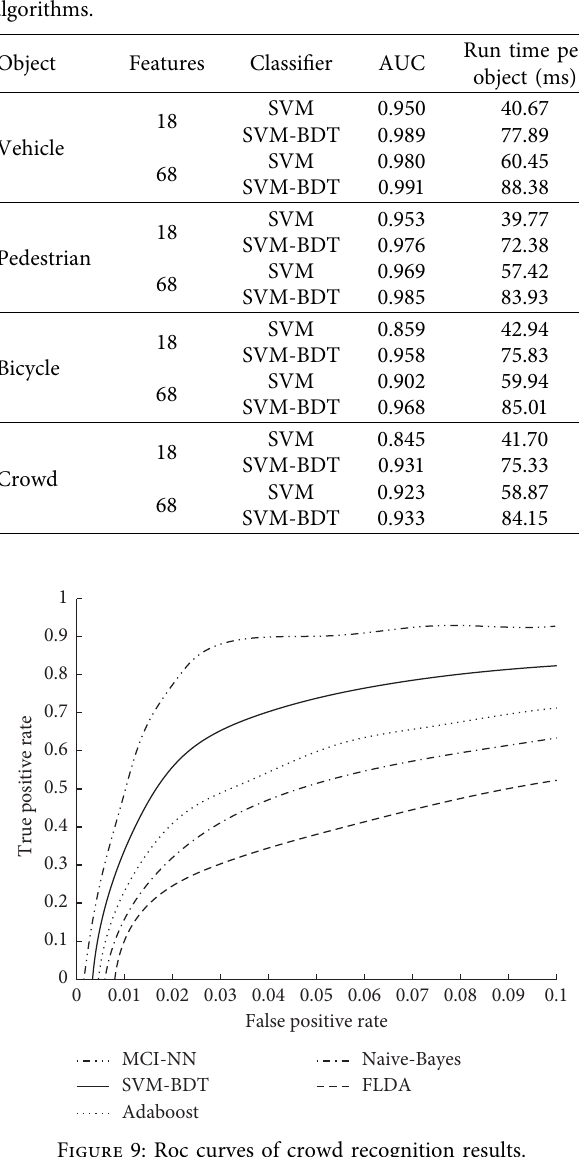
Figure 9: Roc curves of crowd recognition